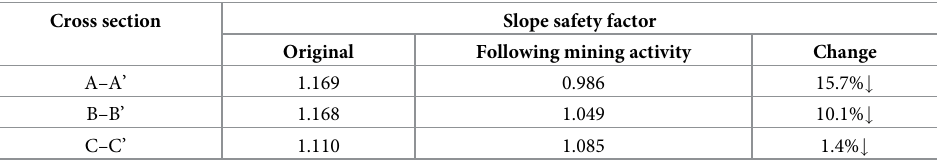
Table 4. Change in slope safety factor following longwall mining